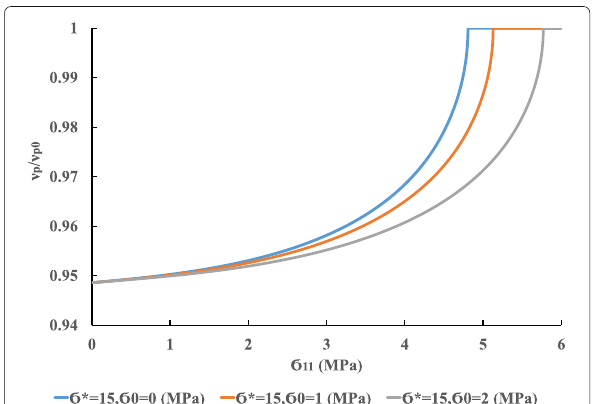
Fig. 4 Longitudinal wave speed variation with respect to external loading. Case of σ 33 amplitude value variation